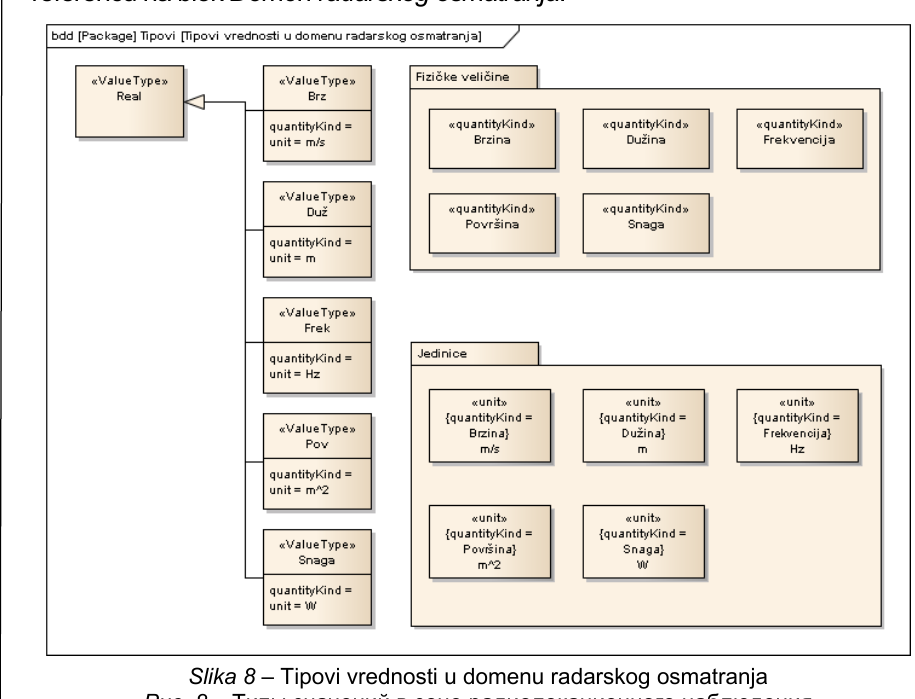
Рис . 8 – Типы значений в зоне радиолокационного наблюдения Figure 8 – Value types in the radar surveillance domain Na slici 10 prikazan je parametarski dijagram koji se odnosi na blok KontekstMaksimalnogDometa